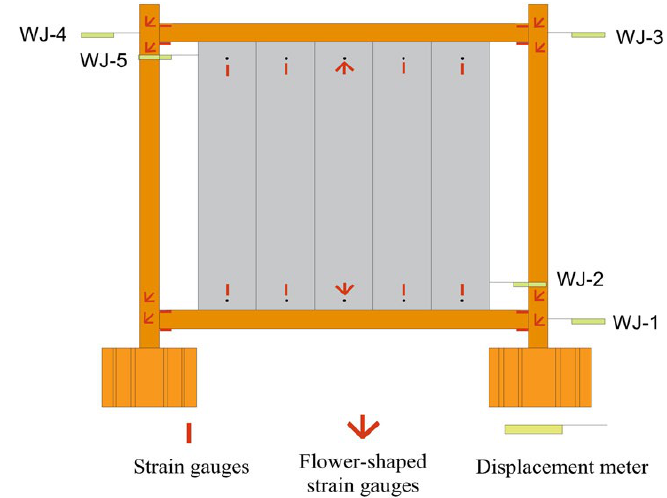
Figure 9. The measuring point arrangement.